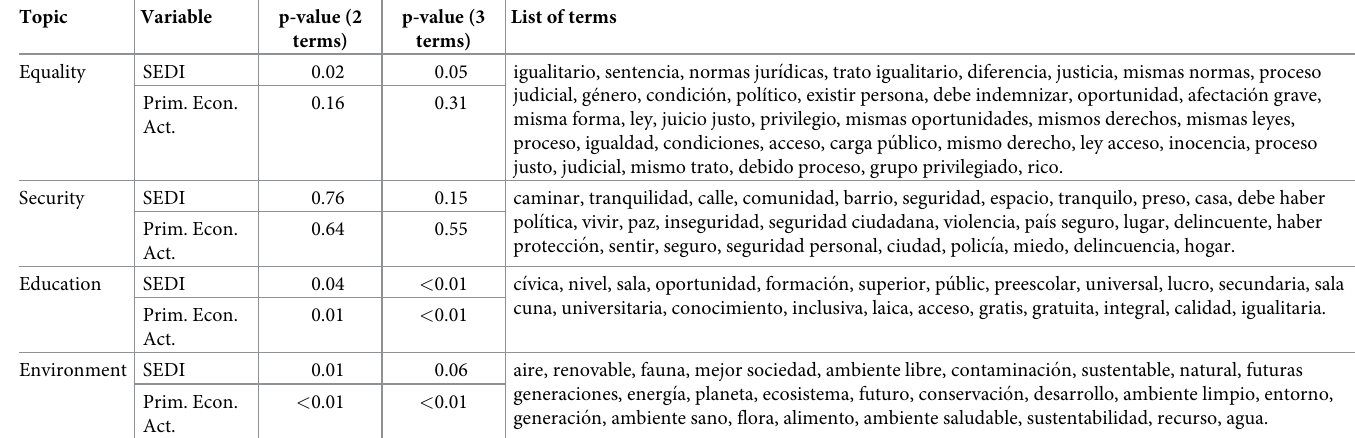
Table 4. p-values, Chi-Square test for differences in the proportion of the argument